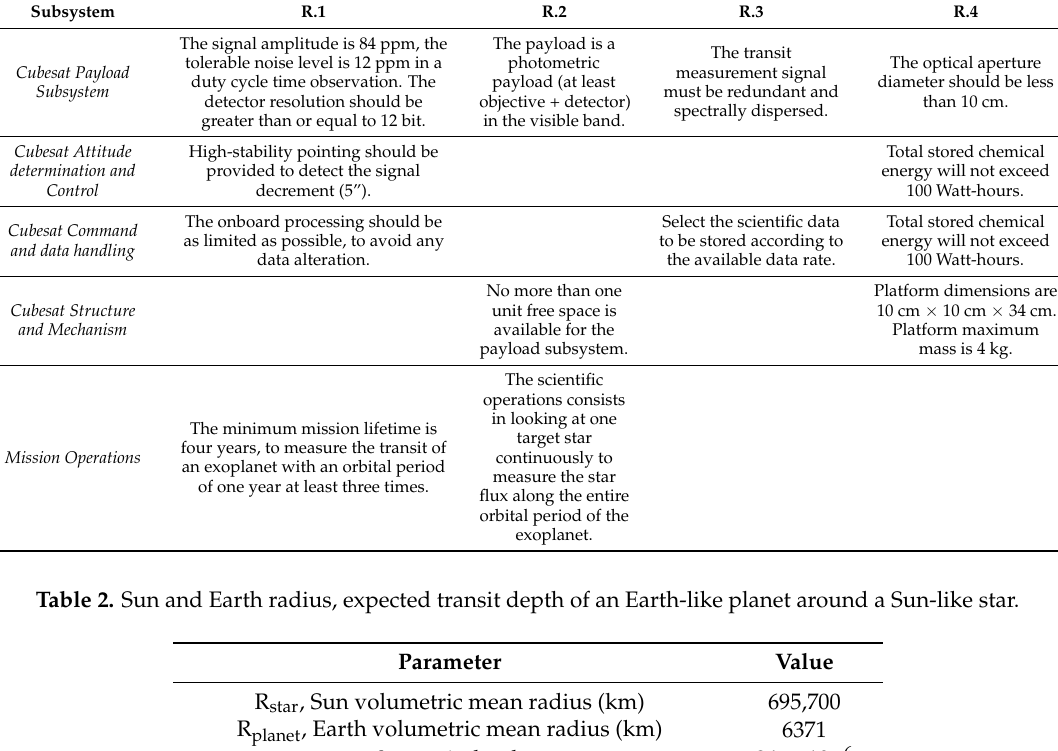
Table 1. Matrix of subsystem requirements.